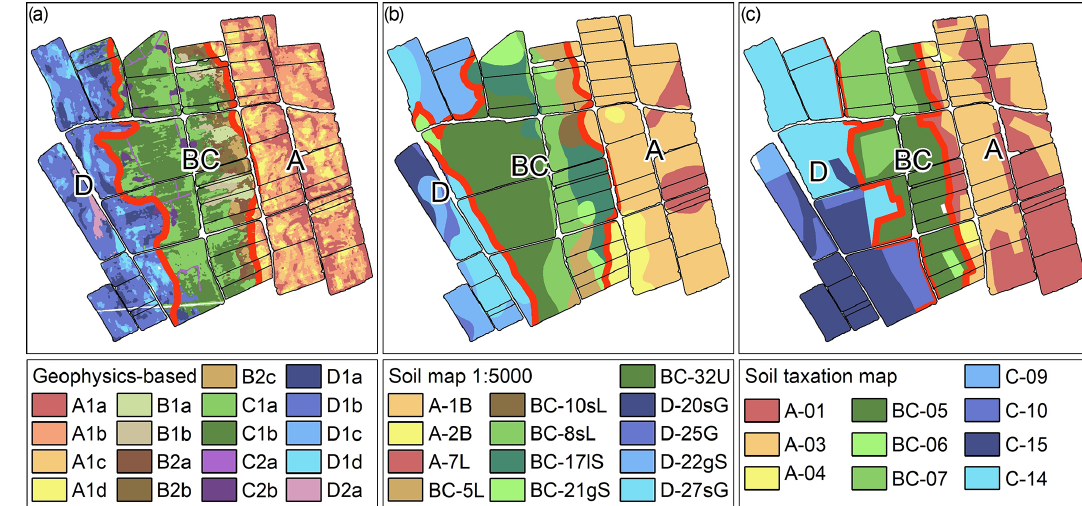
Figure 3. Spatial distribution of soil units and of sub-areas A, BC, and D in (a) the geophysics-based soil map, (b) the 1:5000 soil map, and (c) the soil taxation